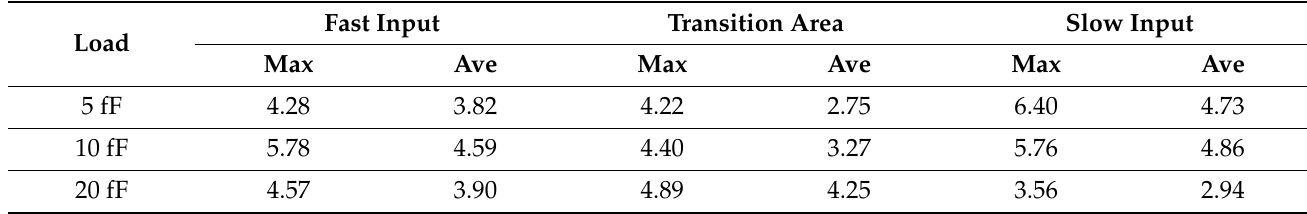
Table 5. Error of min inverter delay at − 3 σ percentile point